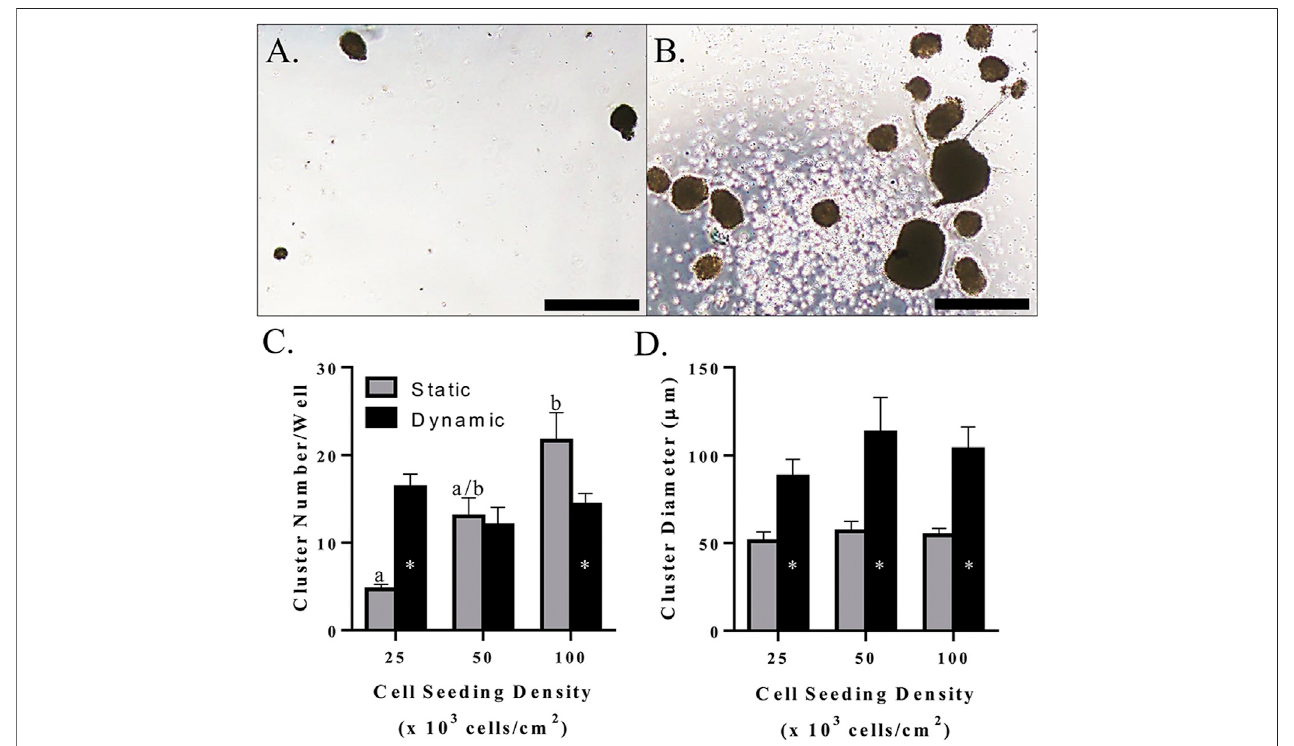
FIGURE 10 | Light photomicrographs of feline ASC clusters (A,B) , LS mean ± SEM cluster number/well (C) , and cluster diameter (D) following pancreatic differentiation without (A) and with (B) dynamic culture during the fi rst two stages of differentiation following culture in three-stage differentiation medium. Scale bars = 200 μ m. Columns with distinct superscripts are signi fi cantly different among cell seeding densities within each culture condition, and columns with different asterisk numbers are signi fi cantly different between static and dynamic culture conditions within seeding densities ( p <